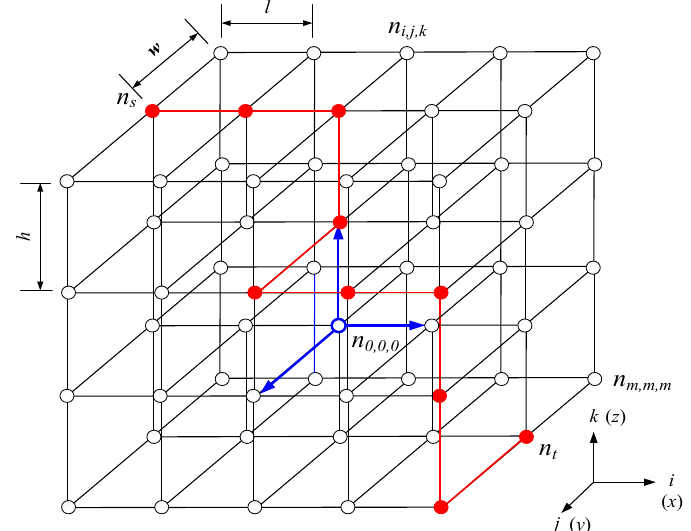
Figure 1. The proposed network model, described by a rectangular 3D lattice.